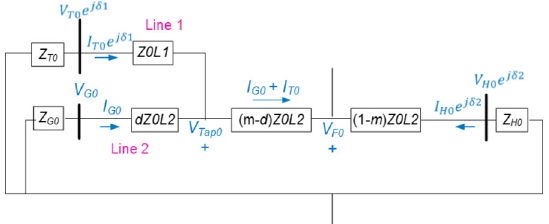
Z 2 L 1 is the negative-sequence impedance of Z 2 L